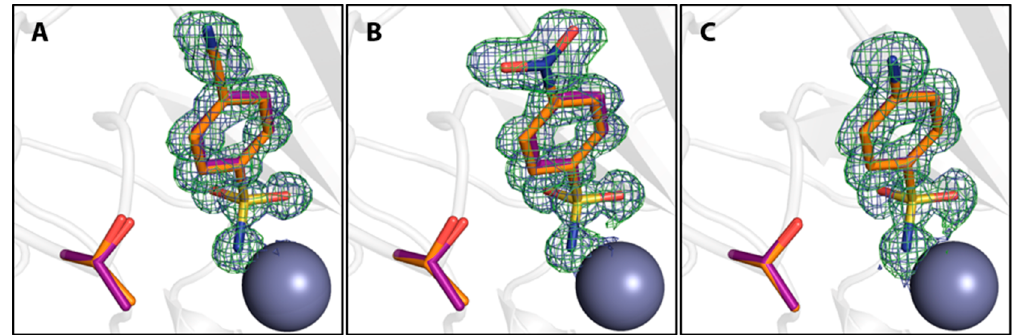
Figure 6. Para-substituted benzenesulfonamides (BSAs) 15 ( A, 4-cyano-), 16 ( B, 4-nitro-), and 17 ( C, 4-amino-) in orange with omit electron density maps in blue at 1 σ (2mFo-DFc) and 3 σ (mFo-DFc) and the side chain of Thr200. Compound 1 is shown as referenced in purple. The Zn II cofactor is shown as gray sphere.